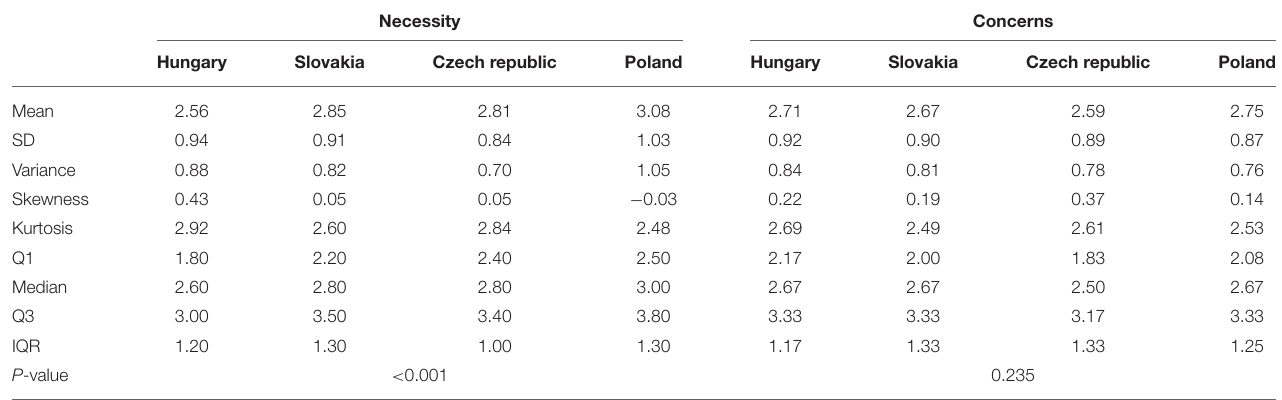
TABLE 2 | Results regarding necessity and concerns of the Visegrad Group